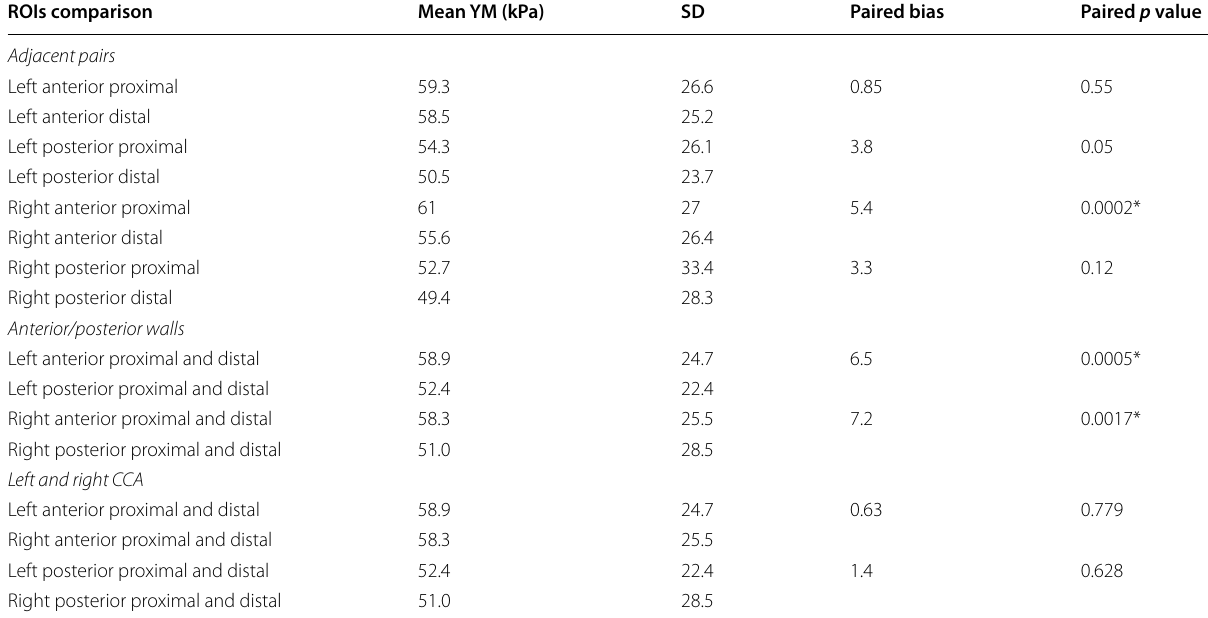
Table 1 Summary of mean YM measurements in all ROIs, comparing differences between adjacent ROIs, anterior and posterior wall and left and right sides